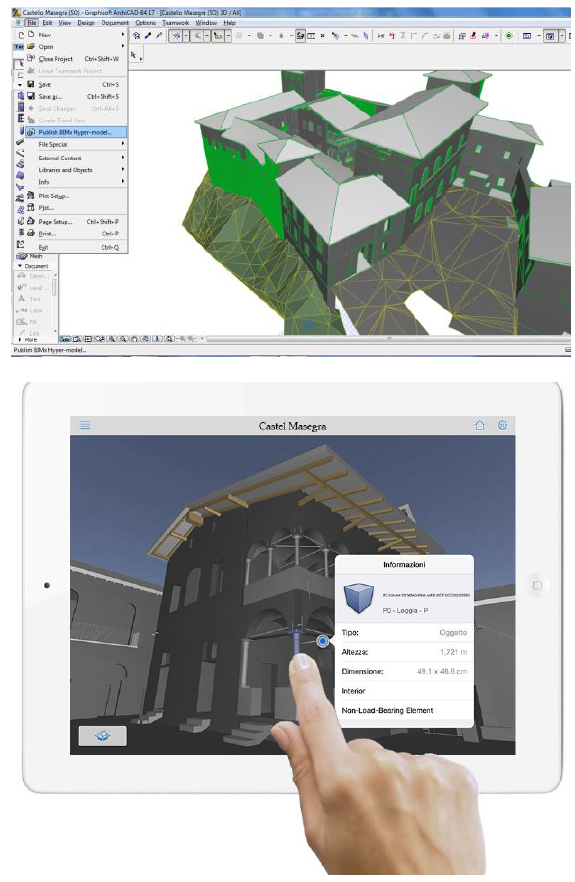
Fig. 8. The object based visualization with BIMx is affected by an information loss for the preliminary file exchange from Revit to